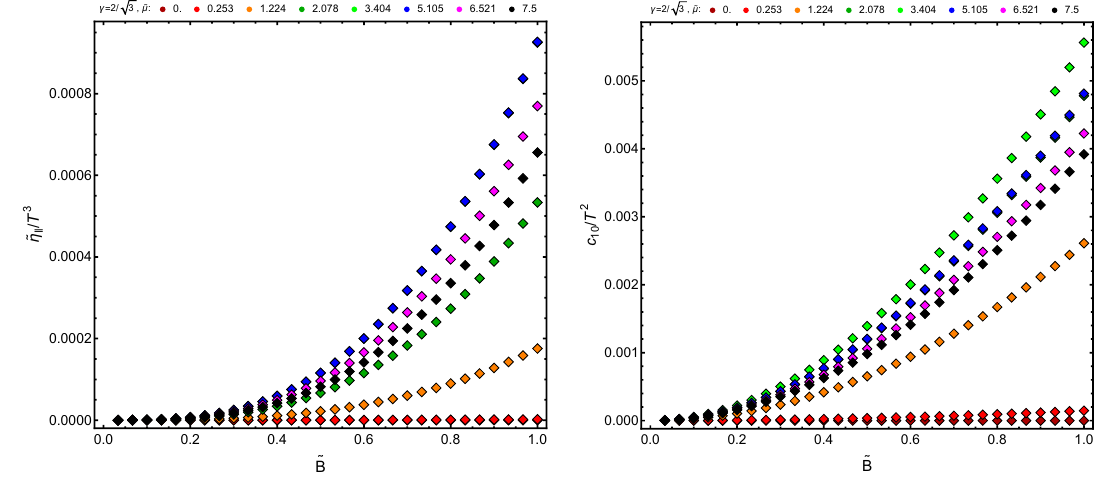
Figure 7 . The dissipationless transport coefficients ˜ η √ anomaly γ = 2 / 3 . Without chiral anomaly, both transport coefficients are zero. The green curve with ˜ µ = 3 . 404 is hidden under the blue